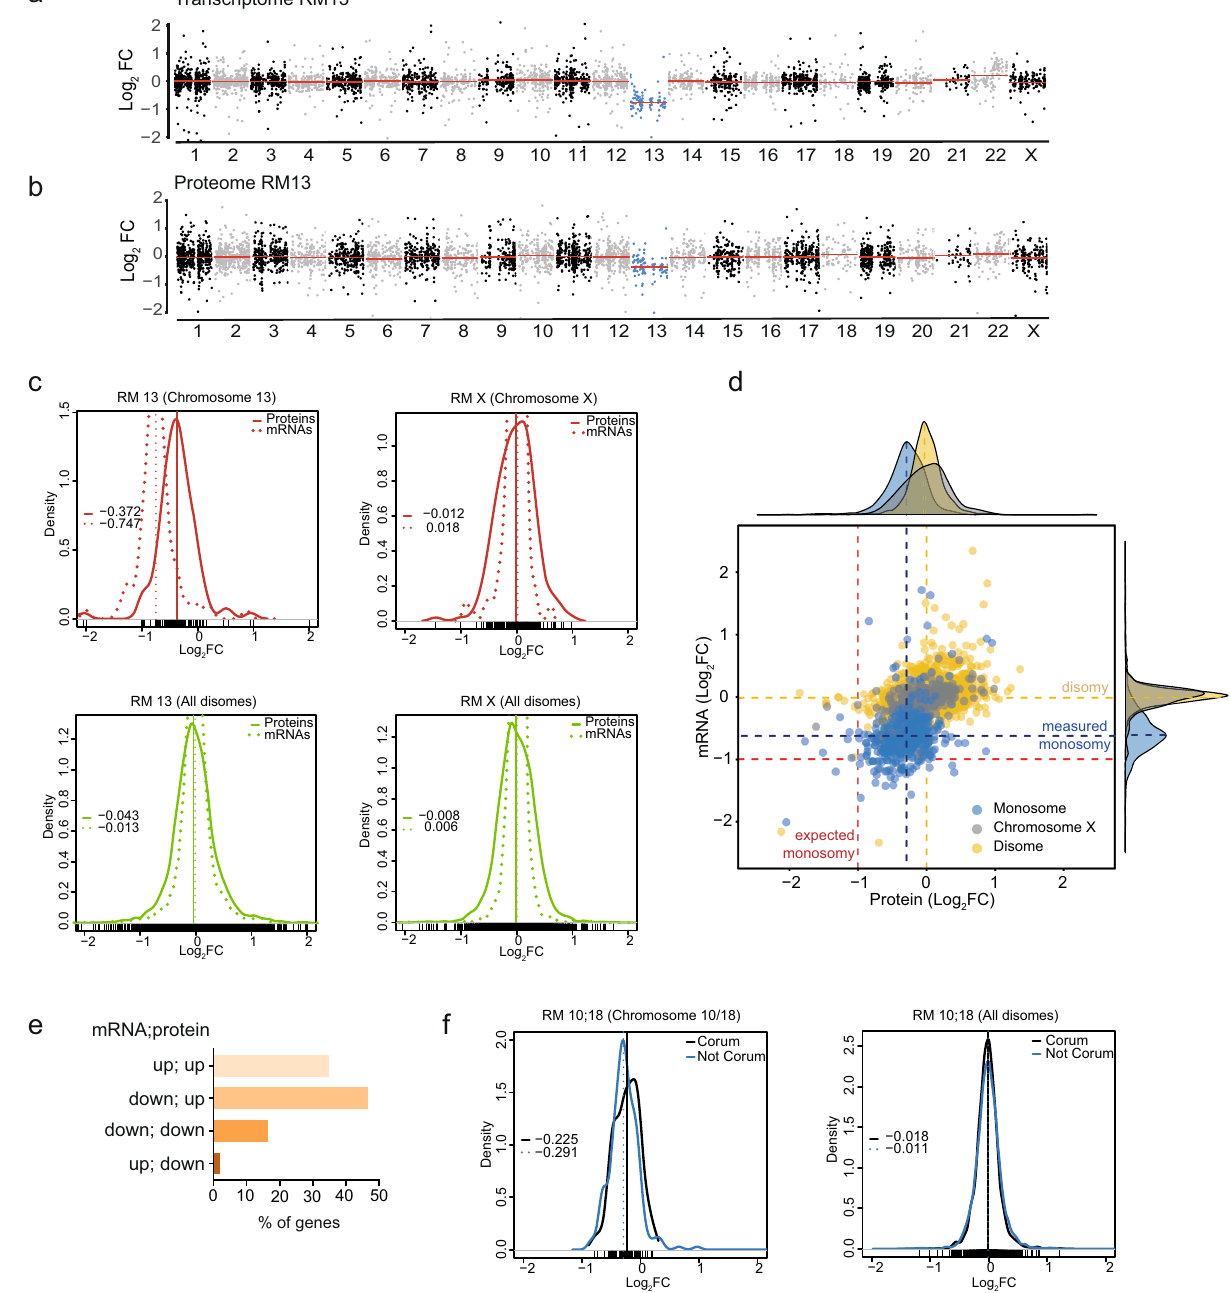
Fig. 3 Expression of genes encoded on the monosomes is adjusted by transcriptional and posttranscriptional mechanisms. a , b The relative abundance of mRNAs and proteins of RM 13 normalized to diploid isogenic parental control were plotted according to their chromosome location. The monosomic chromosome is marked in blue. Red line depicts the median for each chromosome. c Overlays of mRNA (dashed line) and protein (solid line) density histograms. Values of respective medians are plotted in the graph. Upper panels (in red) represent the monosomic chromosome; lower panel (in green) display all other, disomic chromosomes. d Scatter plot showing the log 2 fold change (FC) of mRNAs and proteins encoded on monosomes (blue), disomes (yellow) and chromosome X (gray). The marginal density histograms show the distribution of respective mRNAs and proteins. The expected median fold change of monosomic genes is marked by red dashed lines. The measured median fold changes of monosomic and disomic genes is marked by blue and yellow dashed lines, respectively. e Bar plot shows the percentage of genes assigned to categories according to log 2 FC with a cut-off set to − 0.5. up; up (both mRNA and protein more than − 0.5), down; up (RNA < − 0.5, protein > − 0.5), down; down (both mRNA and protein log 2 FC less than − 0.5), up; down (mRNA > − 0.5, protein < − 0.5). f Density plots of subunit of macromolecular complexes as de fi ned by CORUM database compared to non- CORUM proteins. Left panel displays the monosomic chromosome; the right panel shows the distribution for diploid chromosomes for RM 10;18. The median values are plotted in the